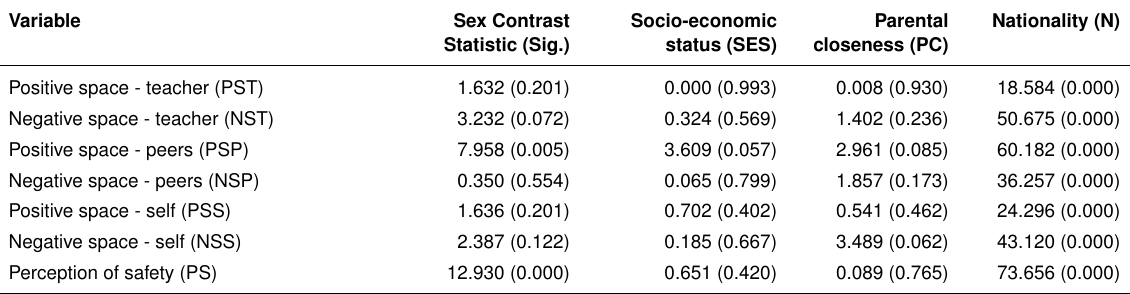
Table 2. Kruskal-Wallis